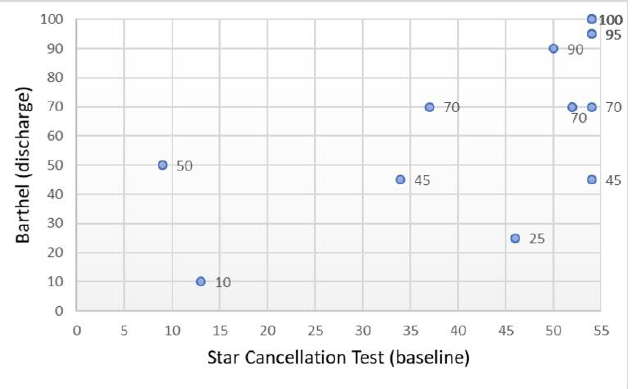
Figure 3. Scatter plot showing the relationship between the cancellation test and functional inde- pendence in ADL ( n = 17).